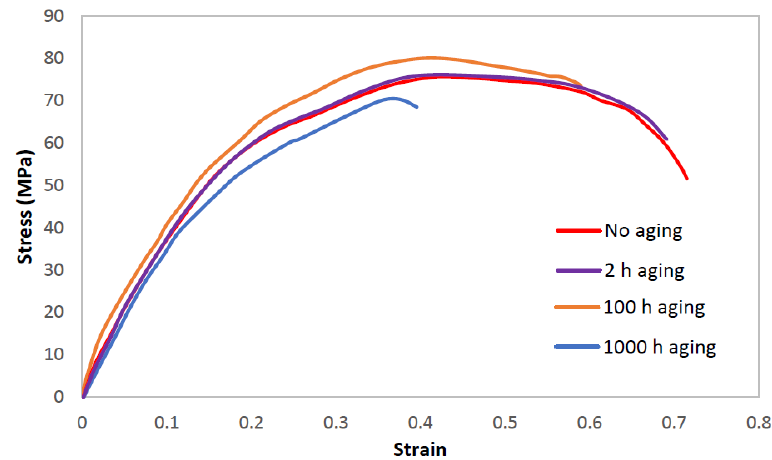
Figure 11. Average shear stress–shear strain curves of thermally aged Cylomax at 150 °C. Table 2. Modulus of elasticity vs. thermal aging duration. Table 3. Extracted mechanical properties of aged and non-aged